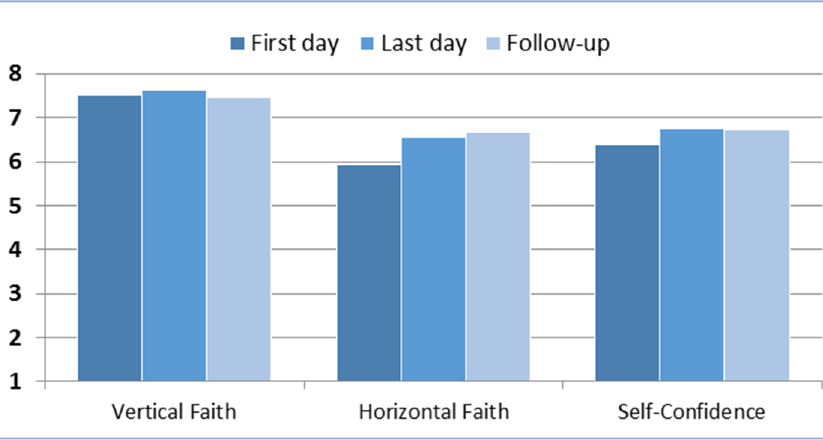
Figure 3: Average of 3 Factors, Measured Over